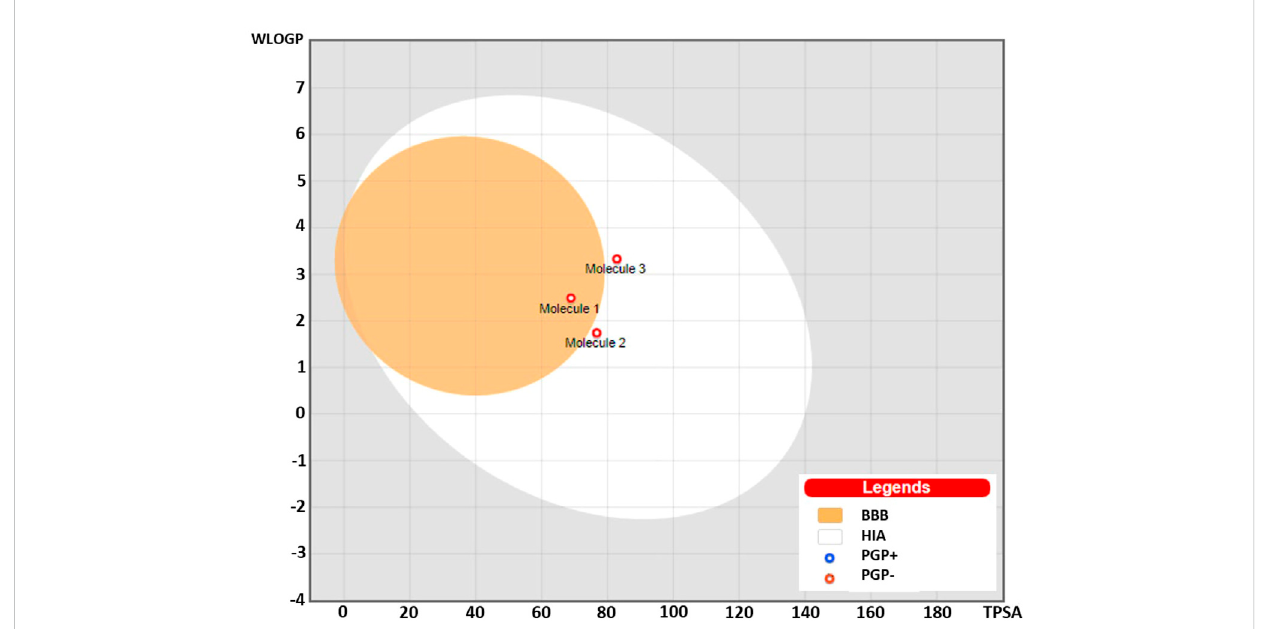
FIGURE 7 BOILED-Egg predictive model showing placement of compounds ( 1 ), ( 2 ), and ( 3 ). Compound ( 1 ) was placed in the yolk suggesting probability for permeabilitytothebrain,whilecompounds( 2 )and( 3 )wereplacedinthewhiteregionpredictinghighgastrointestinalabsorption.Thereddotspredicted to be not ef fl uated from the central nervous system (CNS) by the